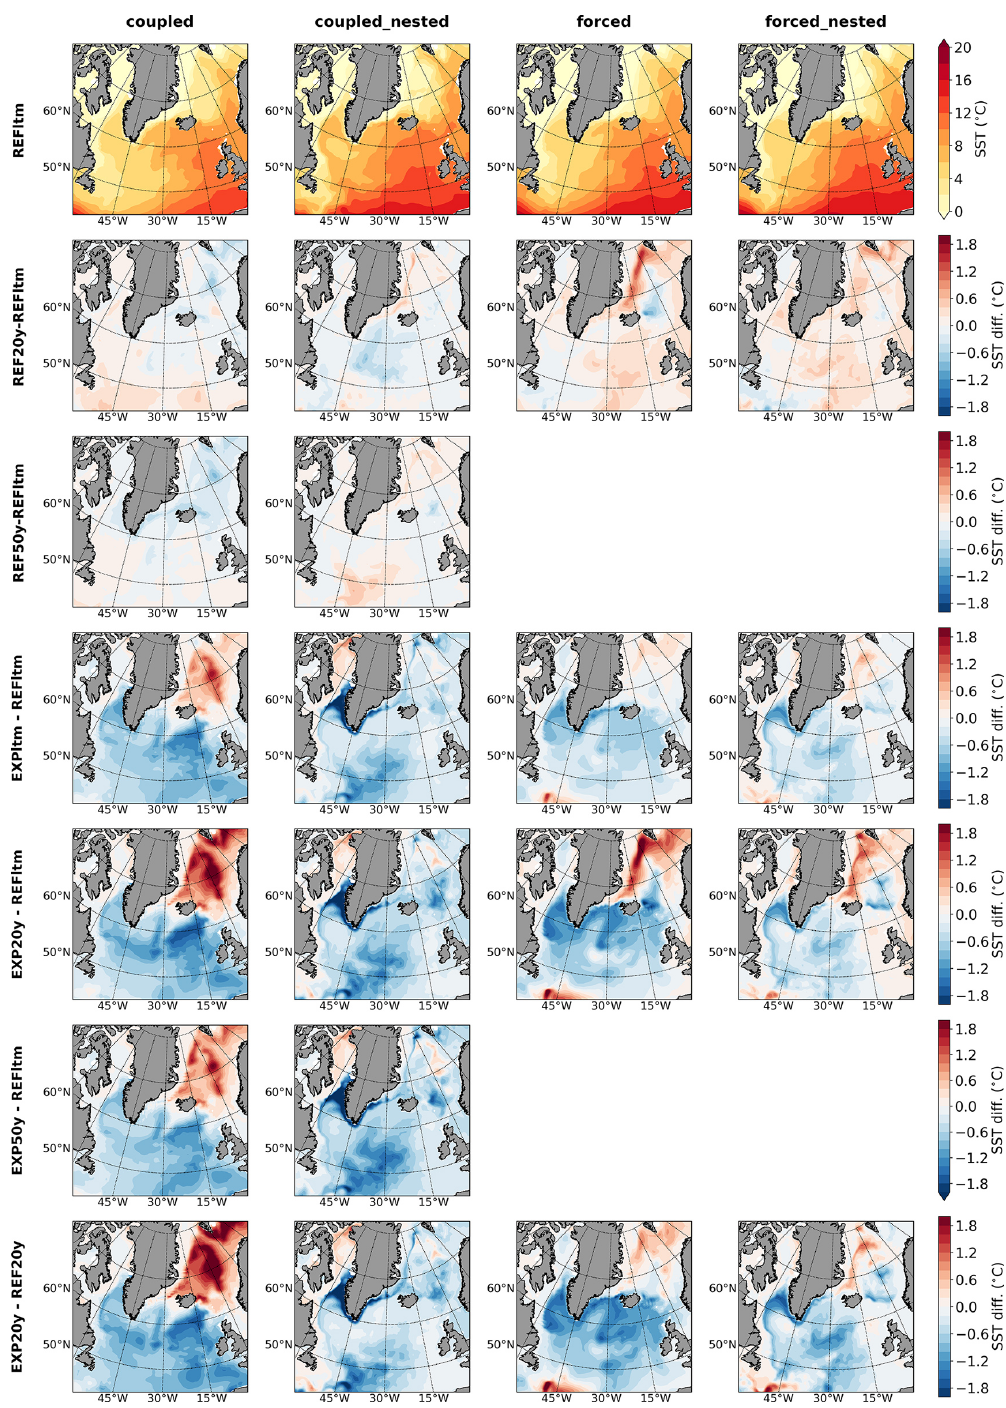
Figure A2. Reference mean state of sea-surface temperature (SST) from all four model configurations (top row) and deviations thereof depending on either time period or freshwater perturbation or both. The labeling on the left reads as follows: REF refers to the unperturbed reference experiments, and EXP refers to the freshwater perturbation experiments; temporal averaging is applied to either the entire run, yielding a long-term mean (ltm, 100 years for the two coupled, 62 years for the two forced configurations), or the years 43–62 (20 years) and 51–100 (50 years, coupled only) after onset of the